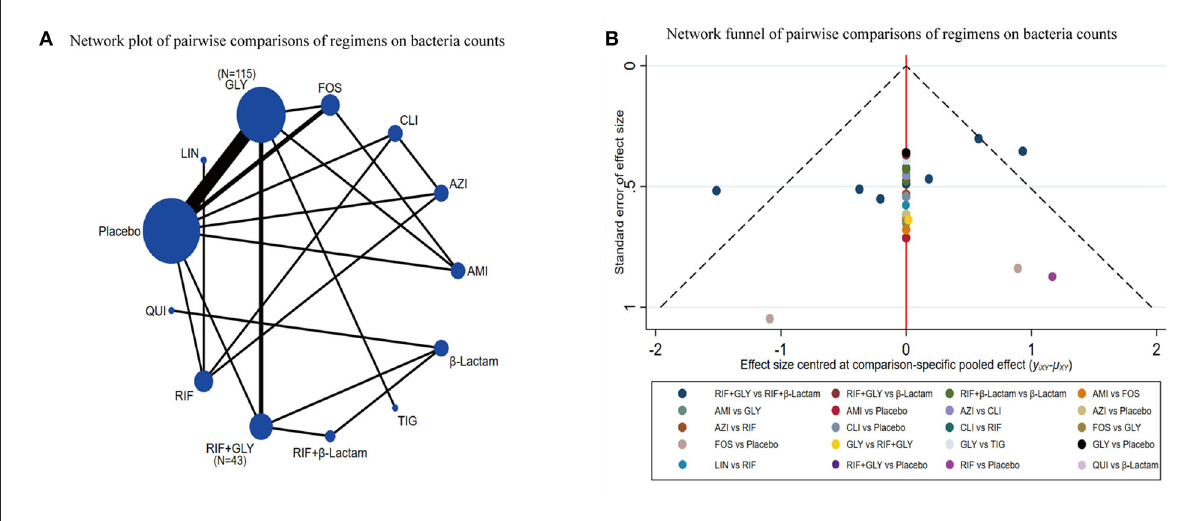
FIGURE5 Network meta-analysis of bacteria counts (A) network graph; (B) the network funnel plot.